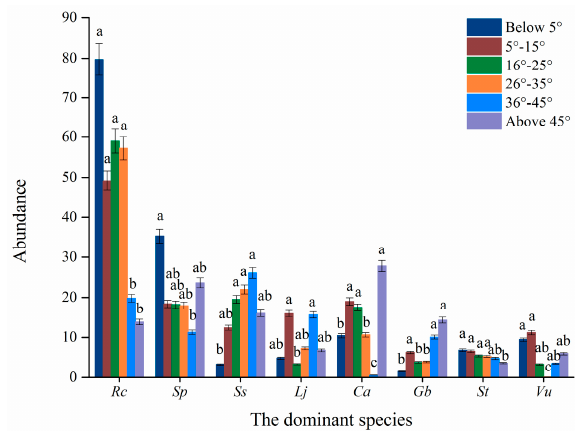
Figure 3. The abundance of the eight dominant species in relation to